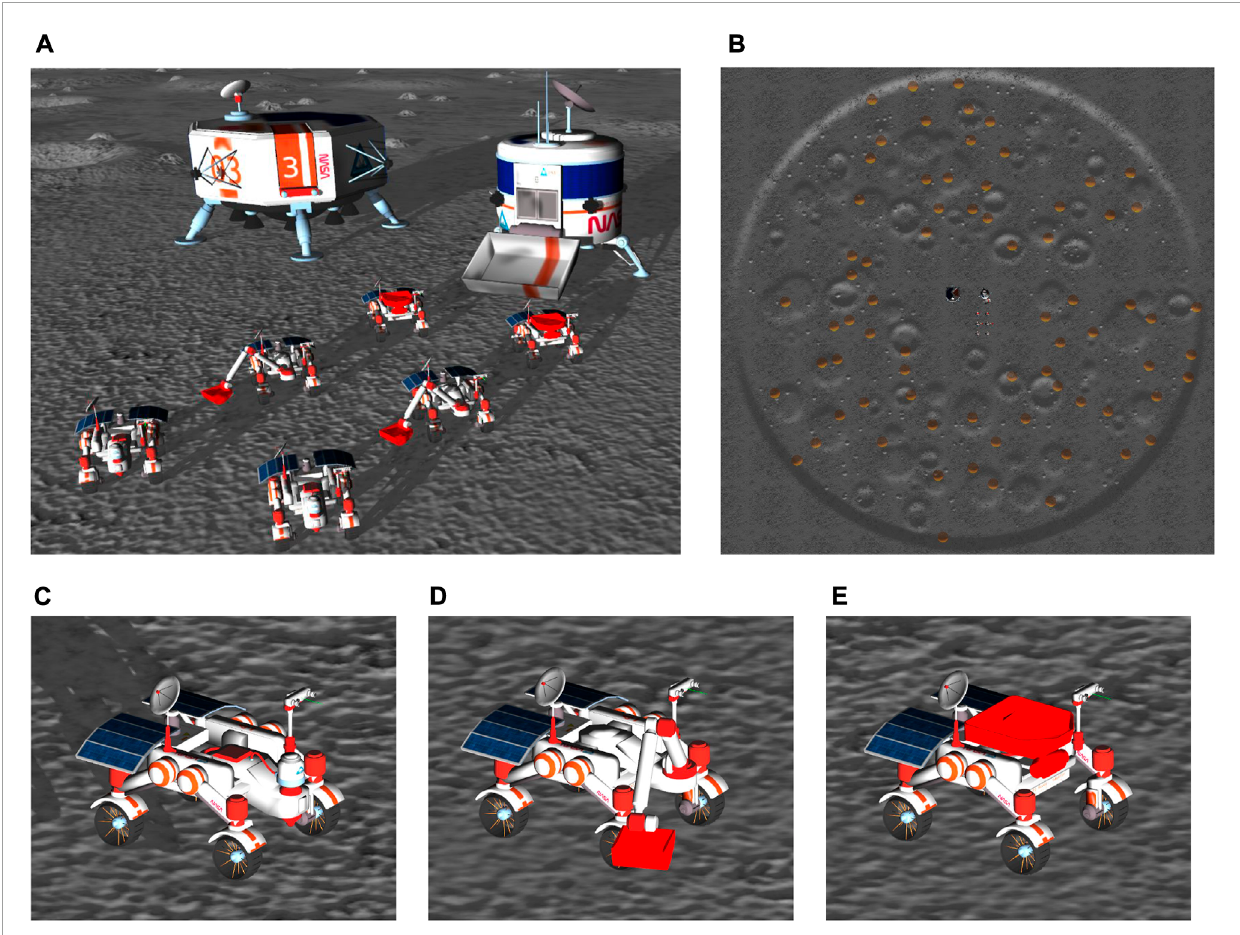
FIGURE 1 Competition simulation setup. (A) Rover initial positions. (B) Randomized lunar terrain consisting of one large crater defining the task area, multiple smaller craters, plateaus, obstacles, and volatile resources hidden under the surface. Rover types: (C) Scout. (D) Excavator. (E)